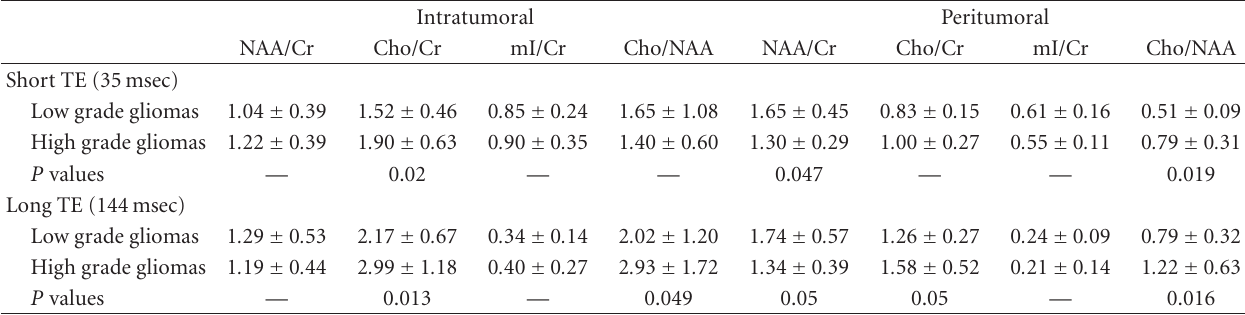
Table 1: Mean values and standard deviation of intratumoural and peritumoral metabolic ratios for short TE (TE = 35msec) and long TE (144msec).